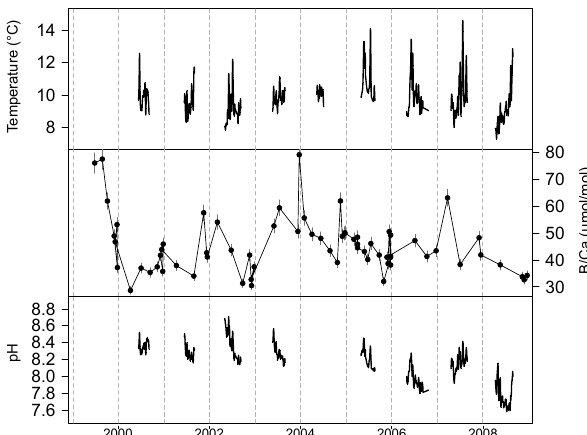
Fig. 7. Plots of pH, M. californianus B/Ca, and temperature. pH and Temperature shown here are binned at 5 days (according to best-fit model) and B/Ca chronology was obtained using the best-fit model. Dashed vertical lines represent a winter growth break, and year la- bels correspond to the start of that year.